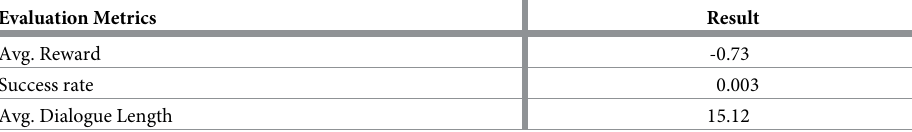
Table 11. SentiVA’s performance for dynamic goal setting